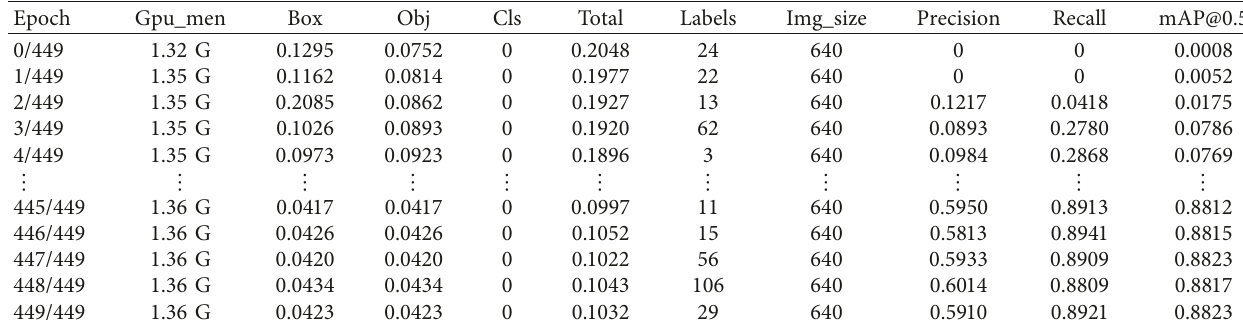
Table 5: YOLO v4 training results.